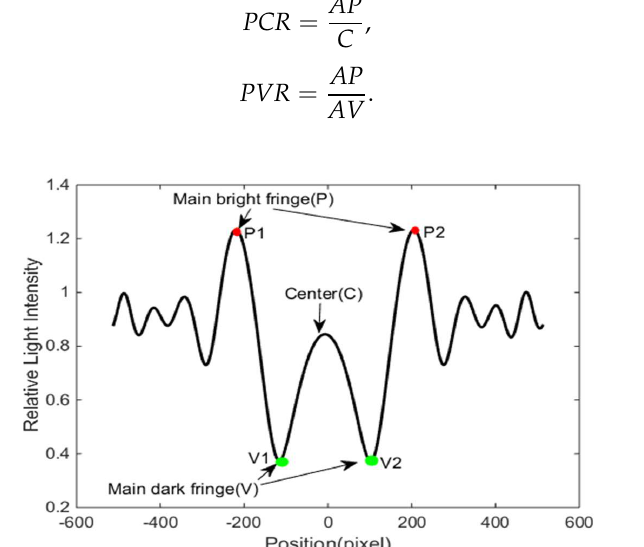
Figure 3. The light intensity value profile of calculated spore diffraction fingerprint.